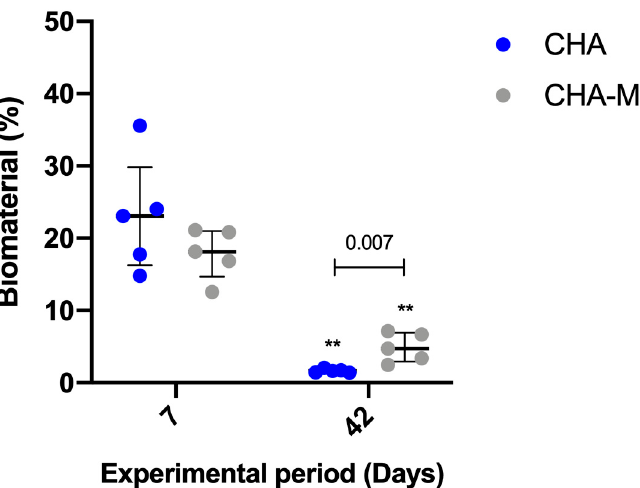
Figure 6. Percentage of biomaterial of CHA and CHA m groups after 7 and 42 days after grafting. Results are presented as a median and IQR ( n = 5). Kruskal–Wallis and Dunn’s post-test were applied to investigate differences between the groups at the same time point. Mann–Whitney test was used to evaluate differences between groups and time points. The ** p = 0.007 represents statistical difference between the same group in different experimental periods. The horizontal bar represents statistical differences between groups over the same period.